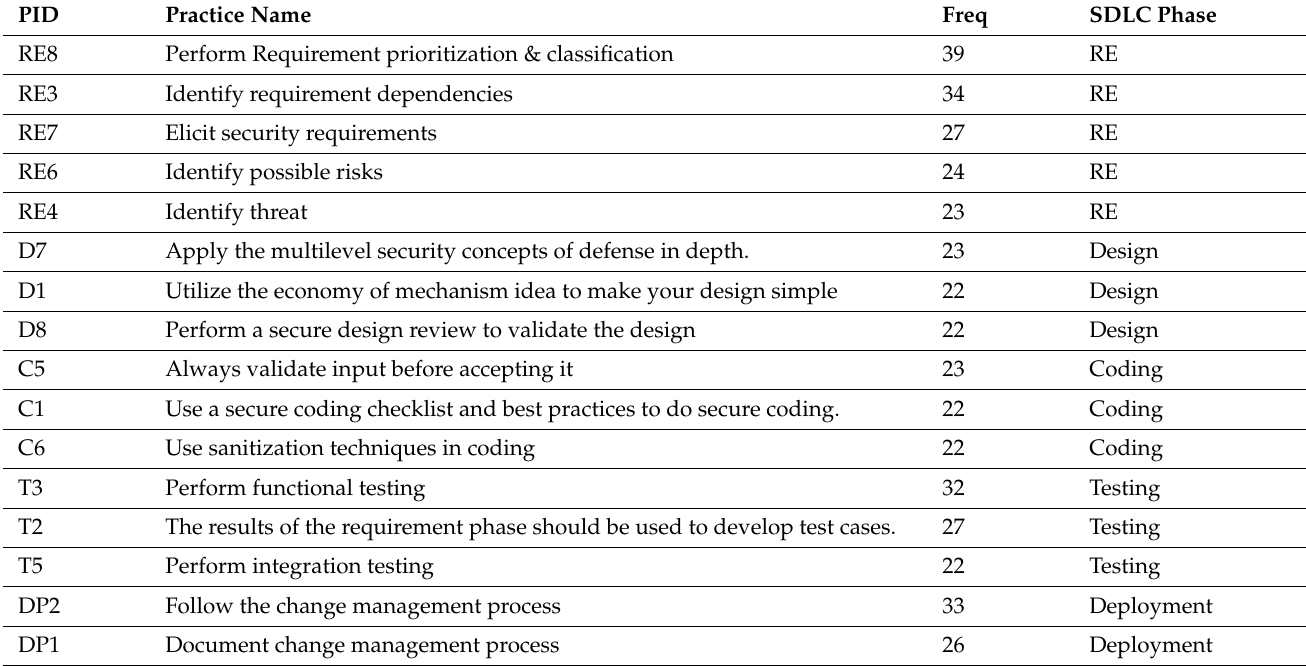
Table 3. Significant GSD security